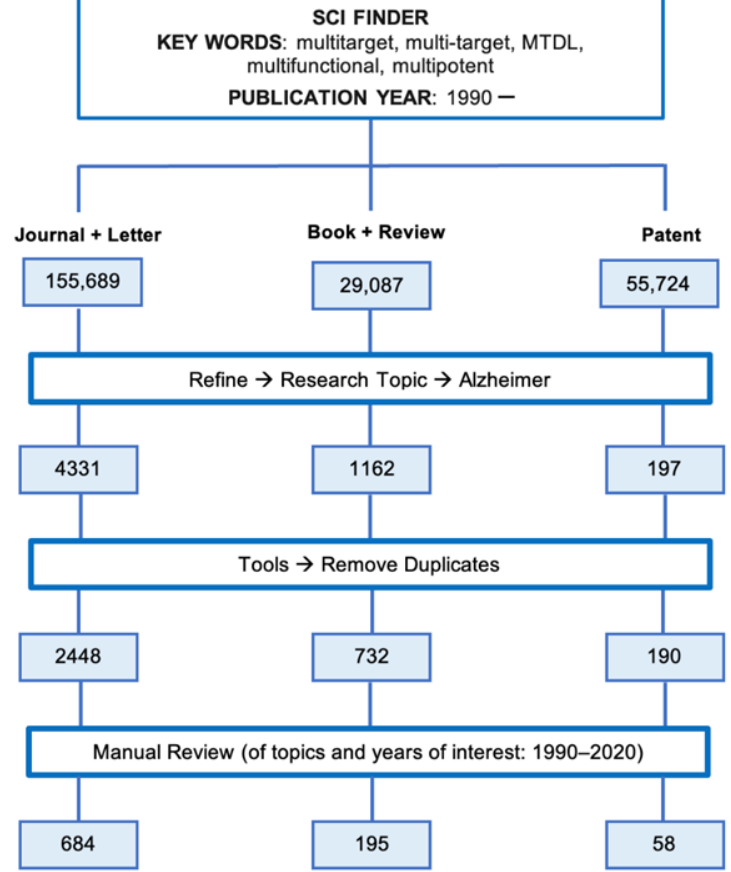
Figure 2. Bibliographic search workflow used for the bibliometric analysis.